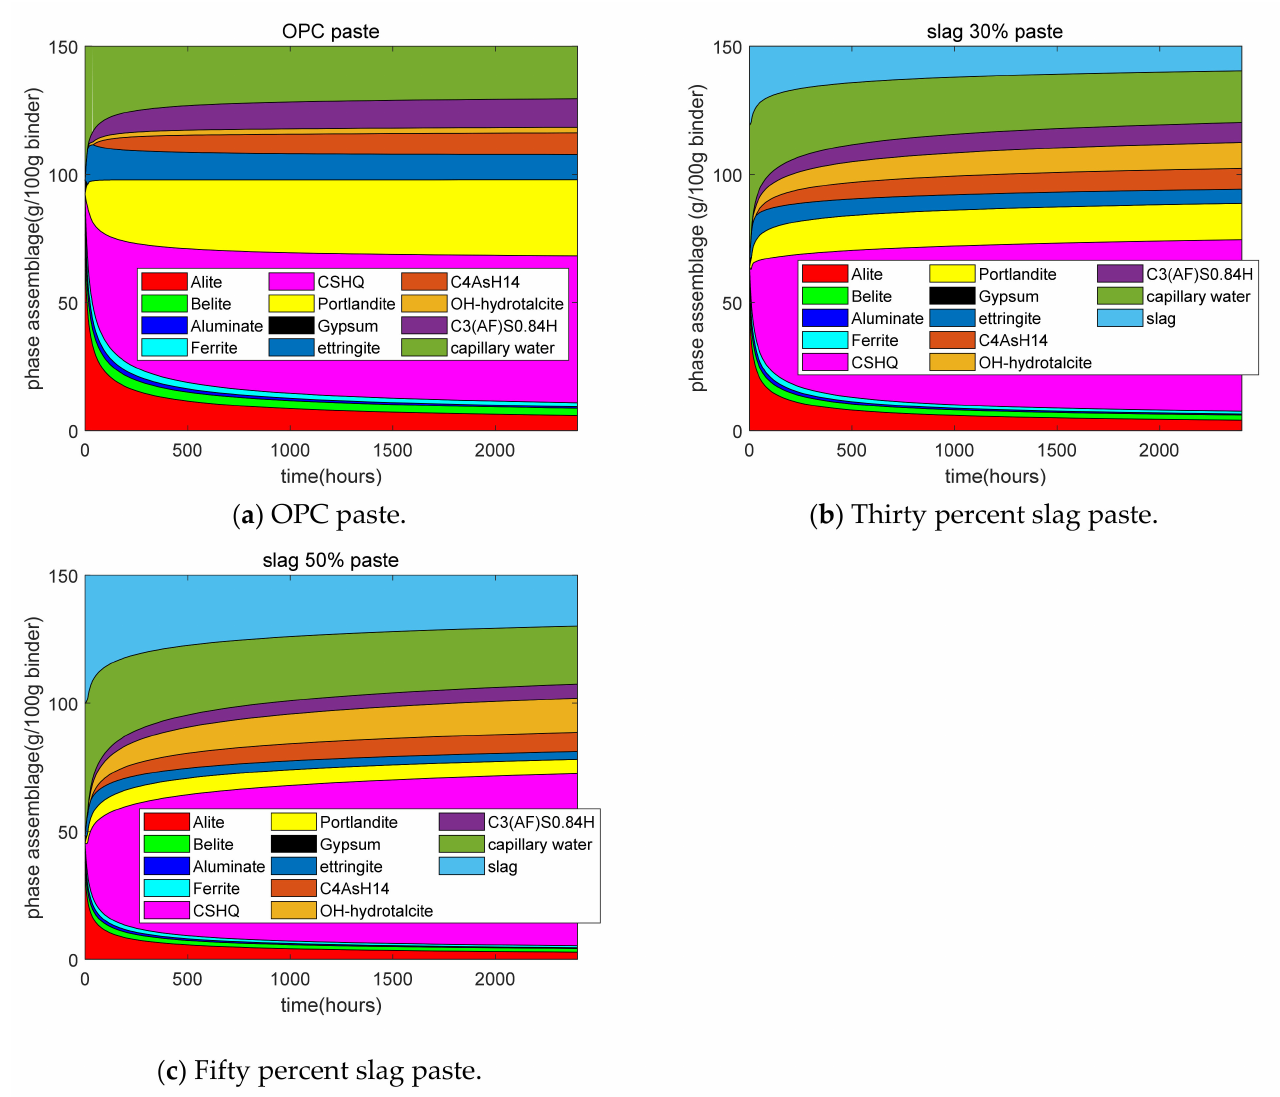
Figure 7. Phase assemblage of cement–slag